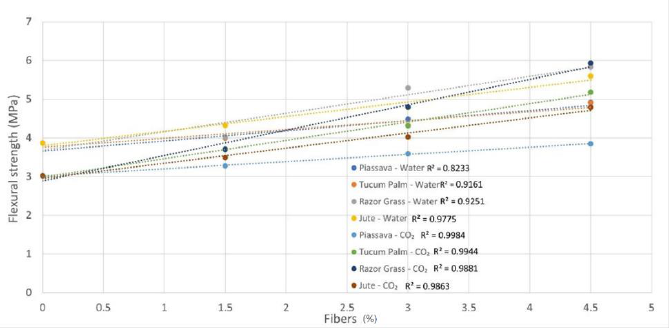
Figure 10. Flexural strength of mortars (28 days) obtained from water and CO 2 curing versus fibers content. R 2 values are presented on the graphs.